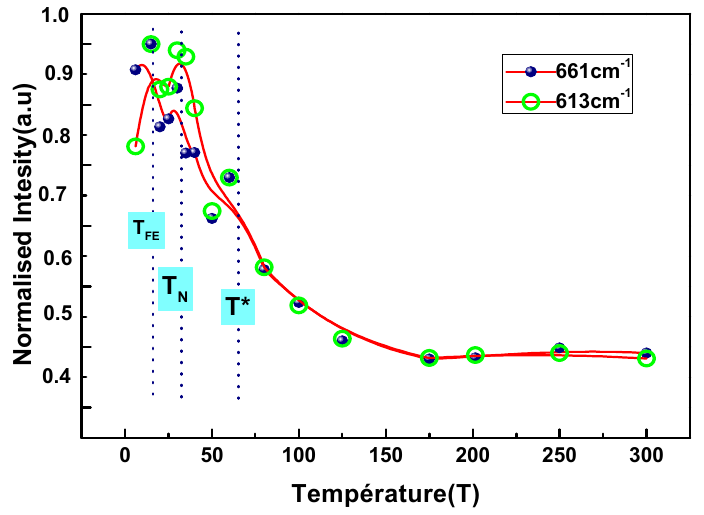
Figure 6. Evolution of the most intense Raman frequencies of A g phonons as a function of the temperature between 6 and 300 K.